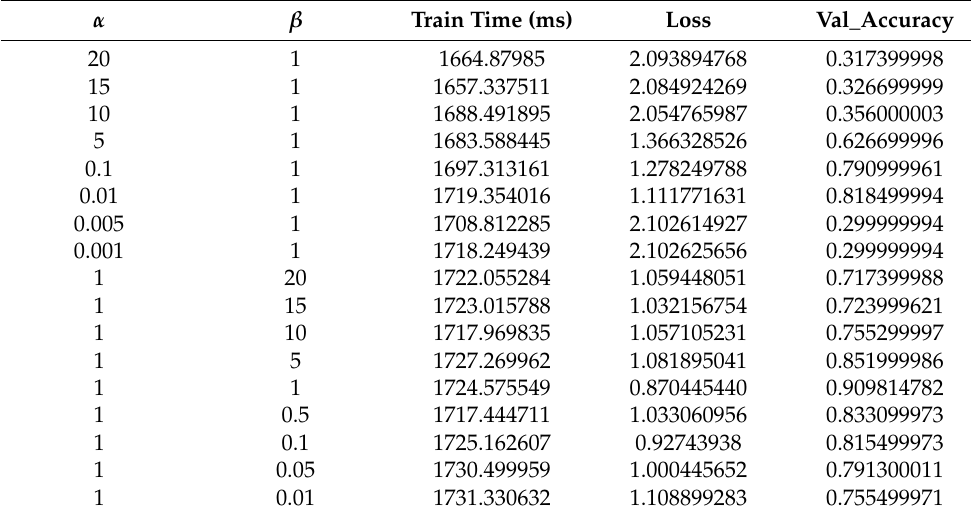
Table 1. Training time, accuracy, and loss with the Smish activation function at different values of α and β